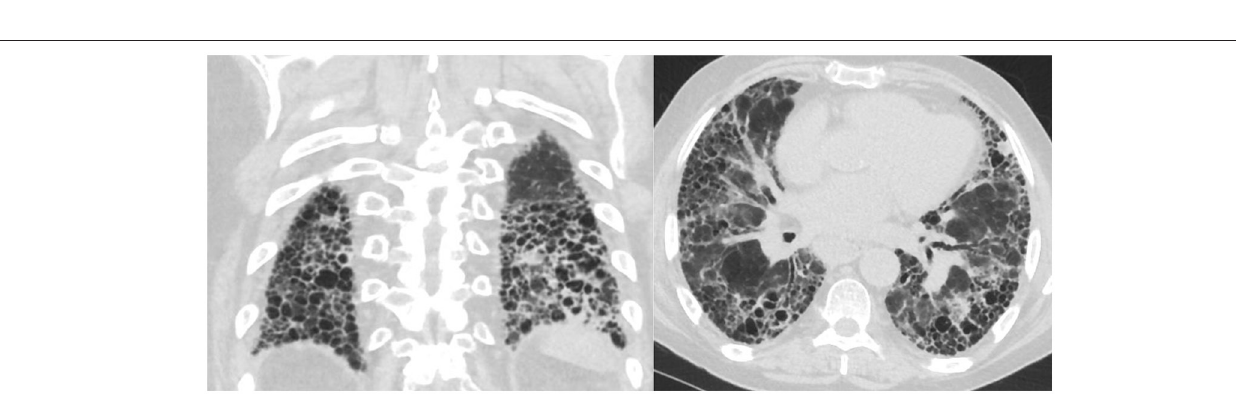
FIGURE 1 | Change from probable UIP pattern to UIP pattern indicative of progressive fibrosis.